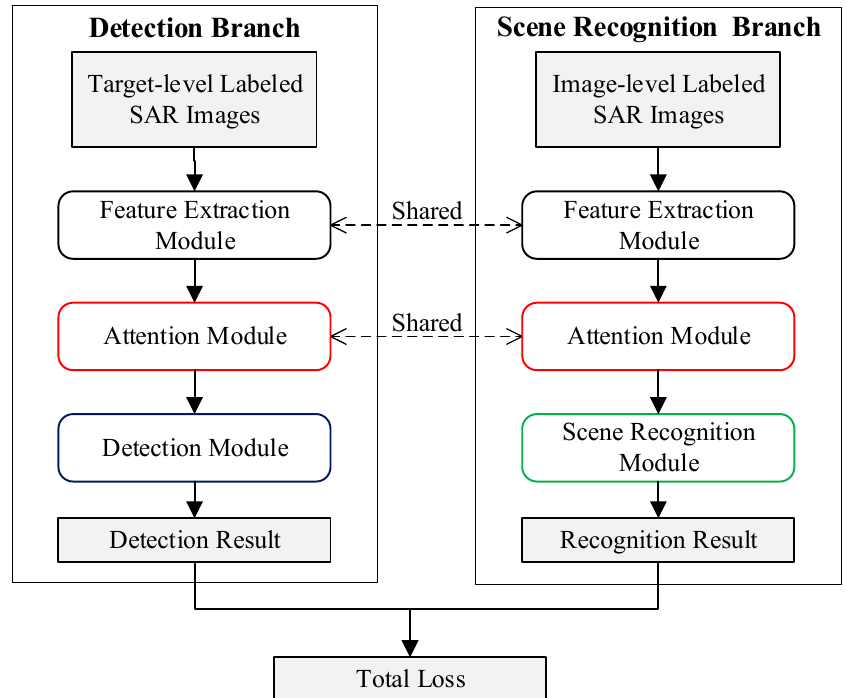
Figure 3. Flowchart of the proposed semi-supervised learning method.